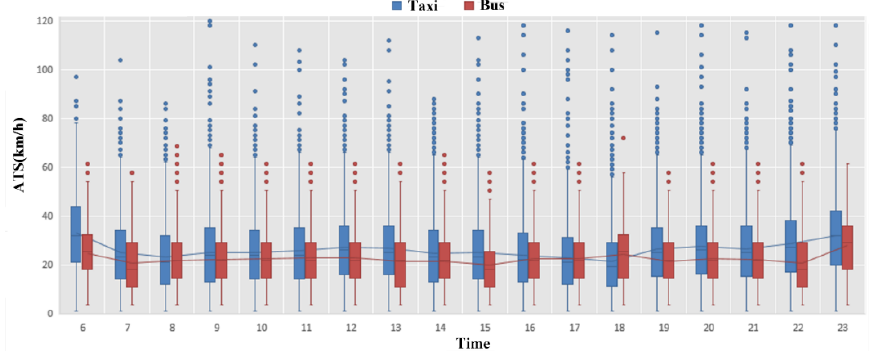
Figure 8. ATS taxi and ATS bus of the congested RSBs (The bus operation times are 06:00-23:00).